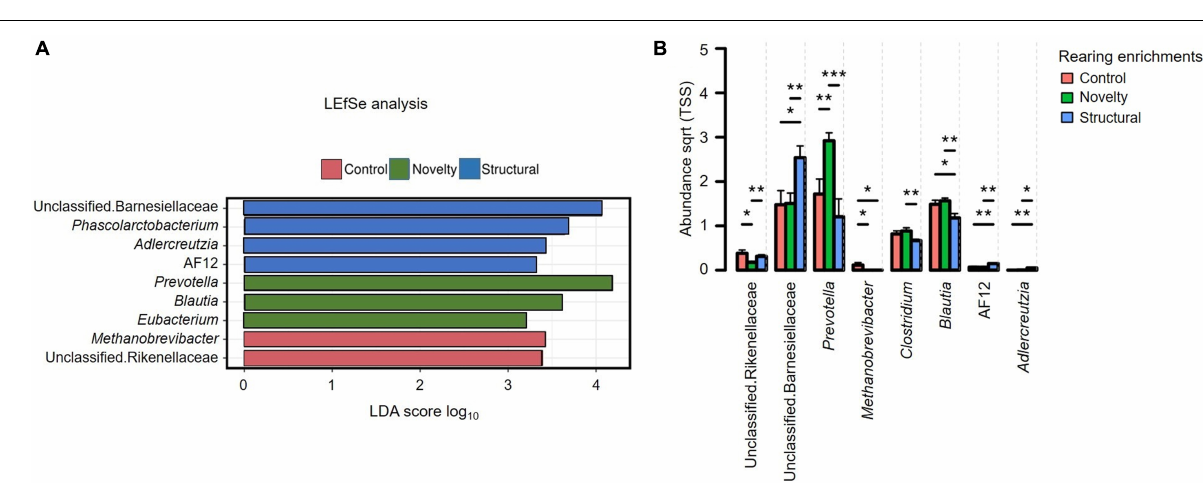
( P = 0.51), Chao1 ( P = 0.54) and Simpson’s index ( P = 0.34) ( Figures 3A–D